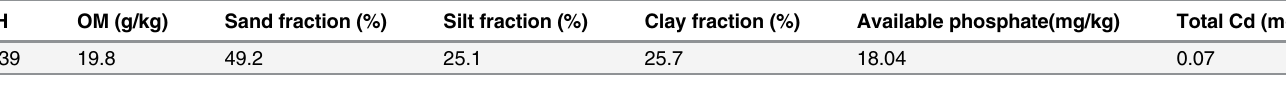
Table 1. Characterization of the soil in the